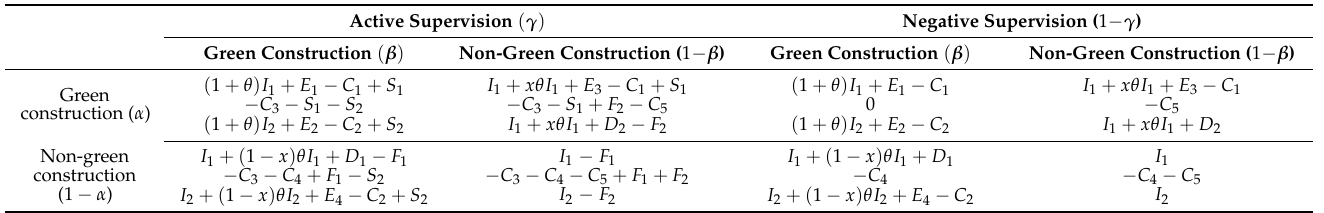
Table 2. Matrix of benefits for game